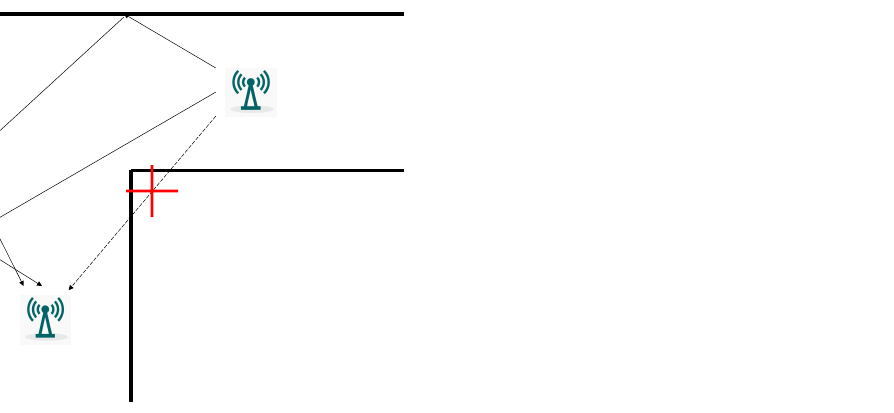
Figure 8. Schematic diagram of NLOS condition and how the multipath error is generated. The black dashed arrow path represents the NLOS condition, and the black solid arrow path represents the multipath